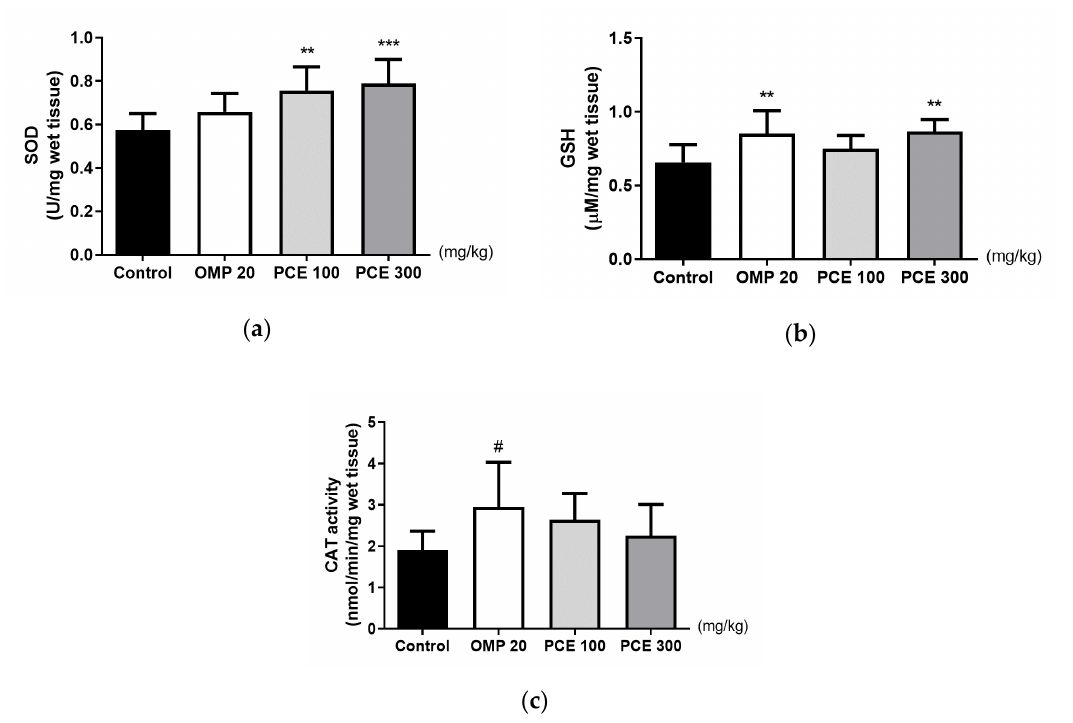
Figure 5. Effects of PCE on the levels of ( a ) superoxide dismutase (SOD), ( b ) glutathione (GSH), and ( c ) catalase (CAT) activity in the stomach tissue of the hydrochloric acid/ethanol (HCl/EtOH)-treated rats. Rats were pre-treated orally with distilled water (control), OMP 20 mg/kg, PCE 100 mg/kg, or PCE 300 mg/kg 1 h prior to HCl/EtOH administration. Values are expressed as mean ± standard deviation. n = 7–8 per group. ** p < 0.01, *** p < 0.001 vs. control by one-way analysis of variance (ANOVA) with Dunnett’s post-hoc test. # p < 0.05 vs. control by Kruskal–Wallis test with Dunn’s multiple comparisons test. OMP, omeprazole; PCE, P. cuspidatum extract.